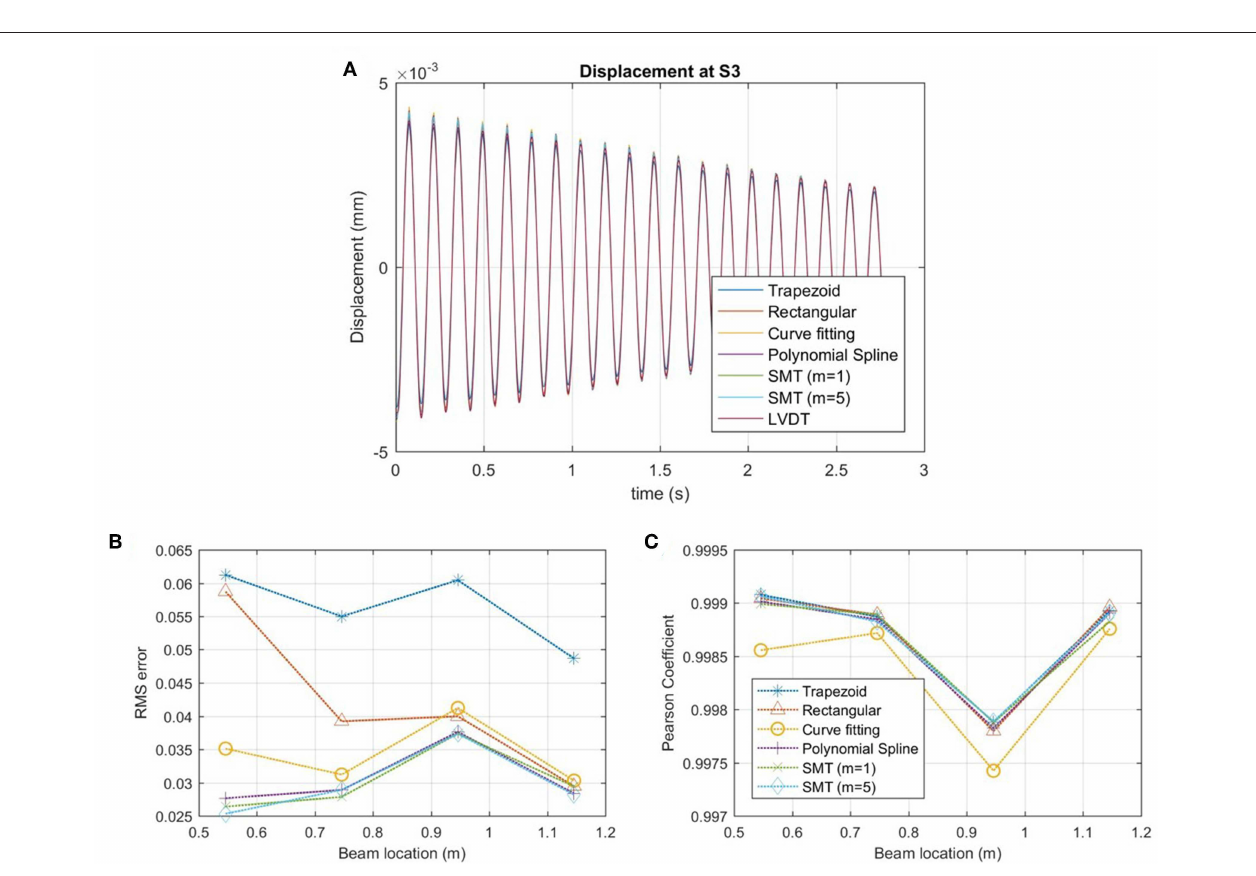
each test, the displacement was determined from the FBG strain response and compared with the displacement measurements from the LVDT sensors. An example of the displacement at the mid-span of the beam for one time segment is shown in Figure 8A . These results are typical for the displacement results for all of the tests and measurement locations, showing there is good agreement between the LVDT displacement and the